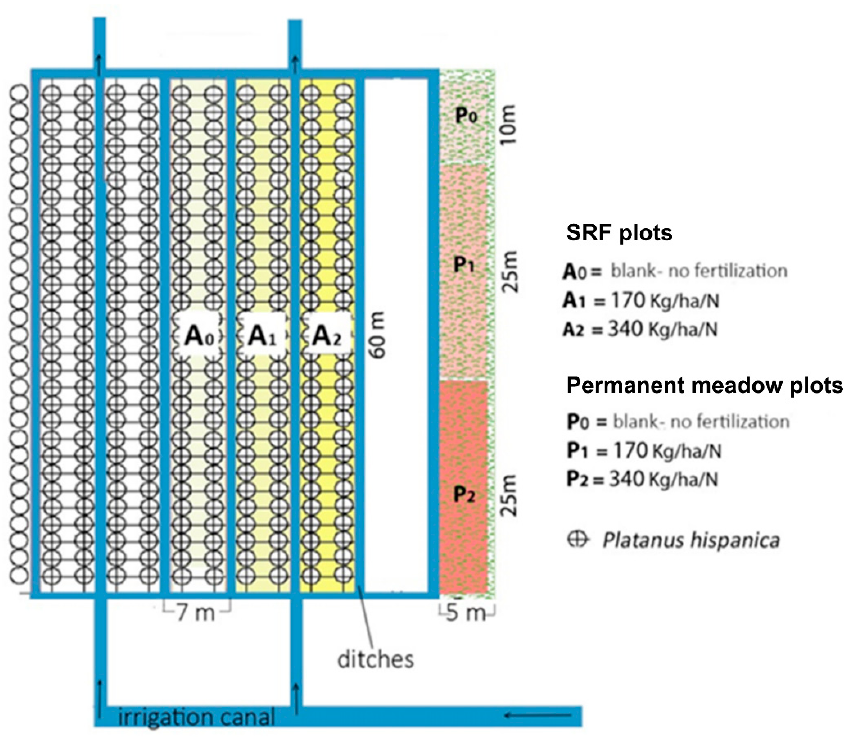
Figure 1. Experimental design: three plots ( A0, A1 and A2 ) are set in the Forested Infiltration Area and three plots ( P0, P1 and P2 ) are set in the permanent meadow. The legend shows the different amount of N added as digestate in each plot.